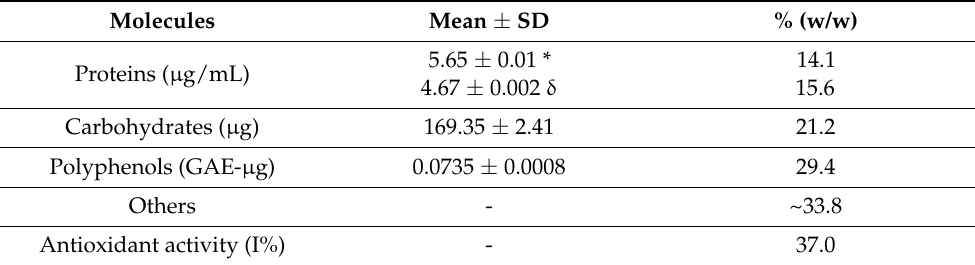
Table 3. Chemical composition of Hemp seeds’ extract (% w/w).